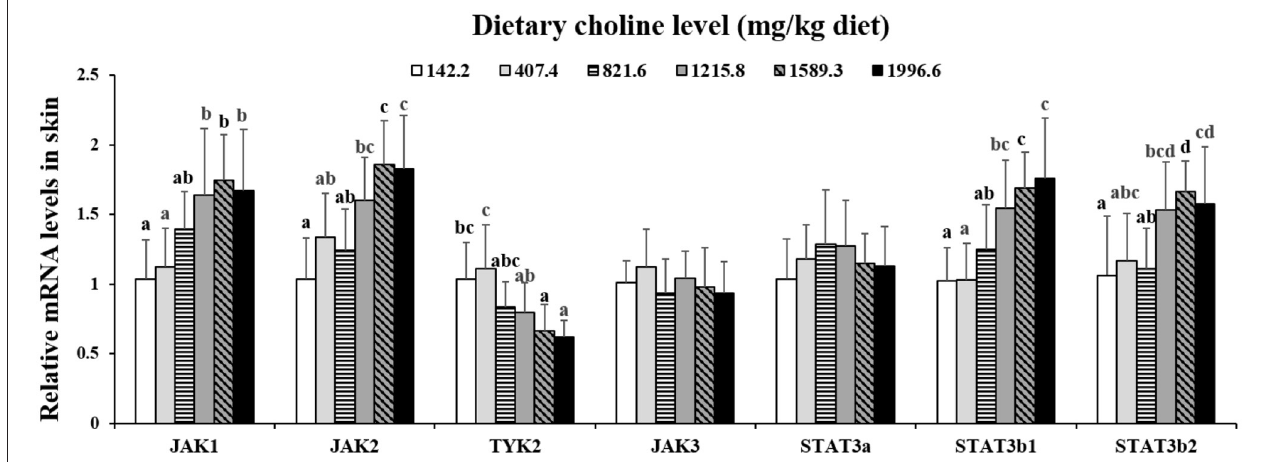
Dietary Choline Reduced Skin